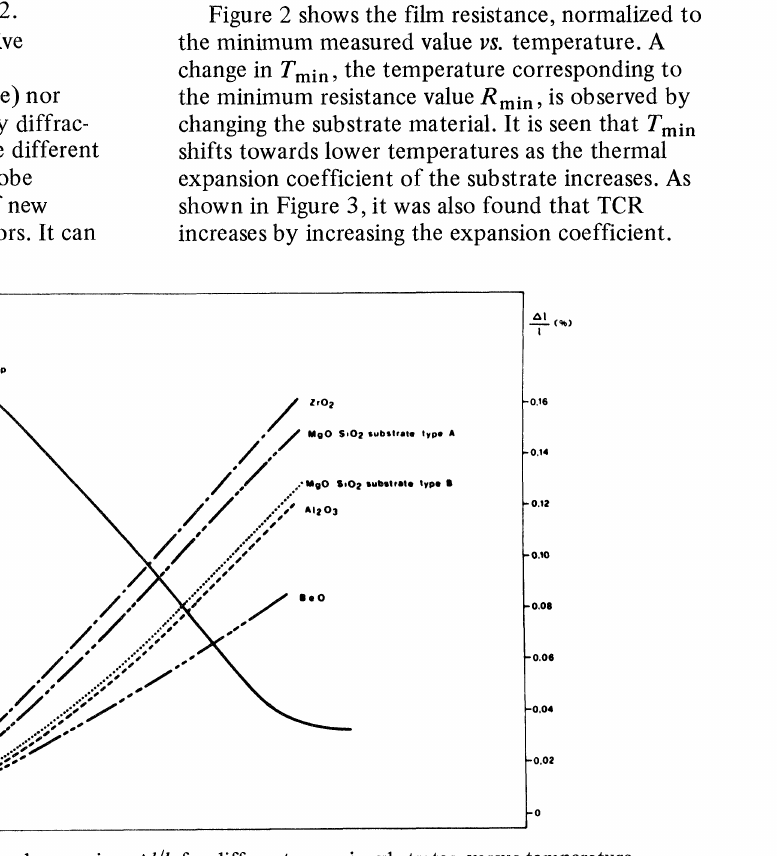
FIGURE Curves of linear thermal expansion, Al/l, for different ceramic substrates, versus